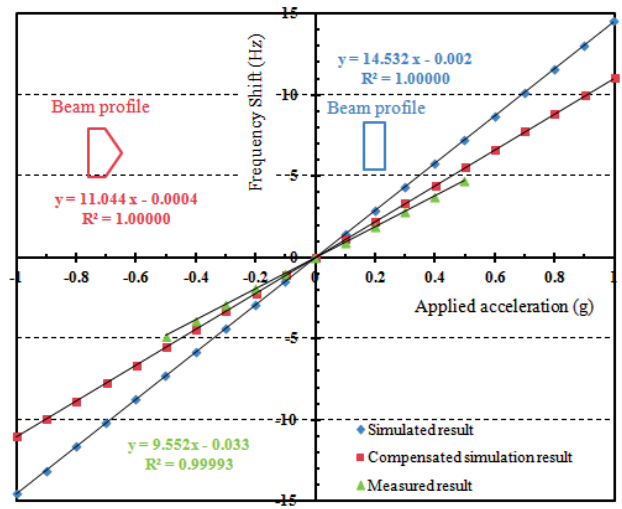
Figure 9. Simulated and measured frequency response under small